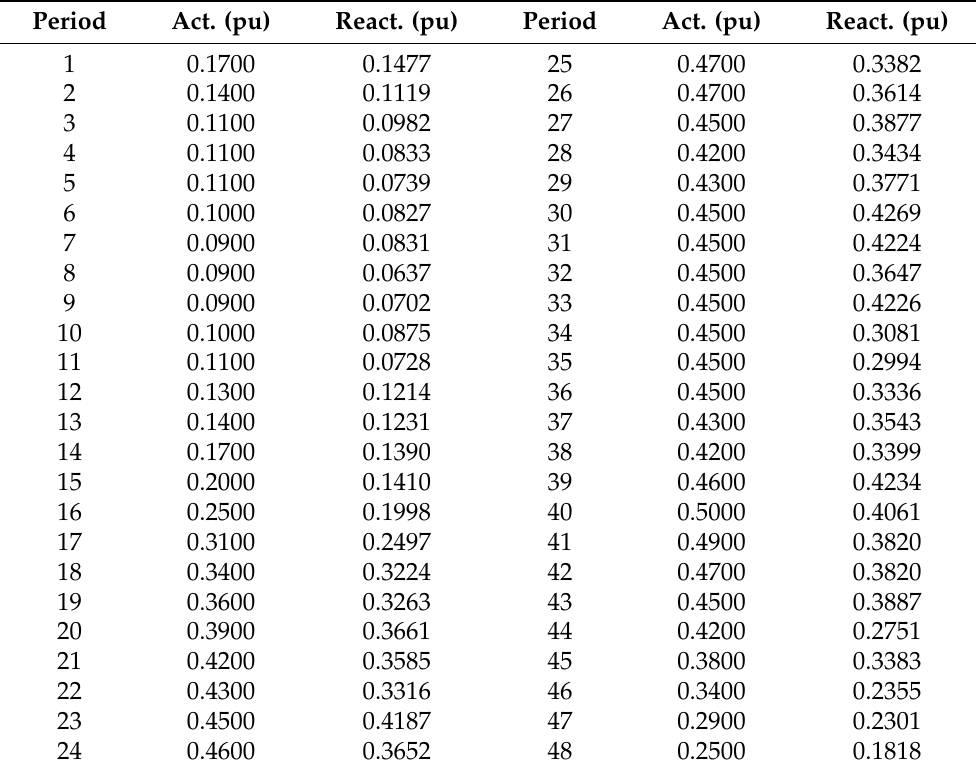
Table 4. Behavior of the daily active and reactive power demands.